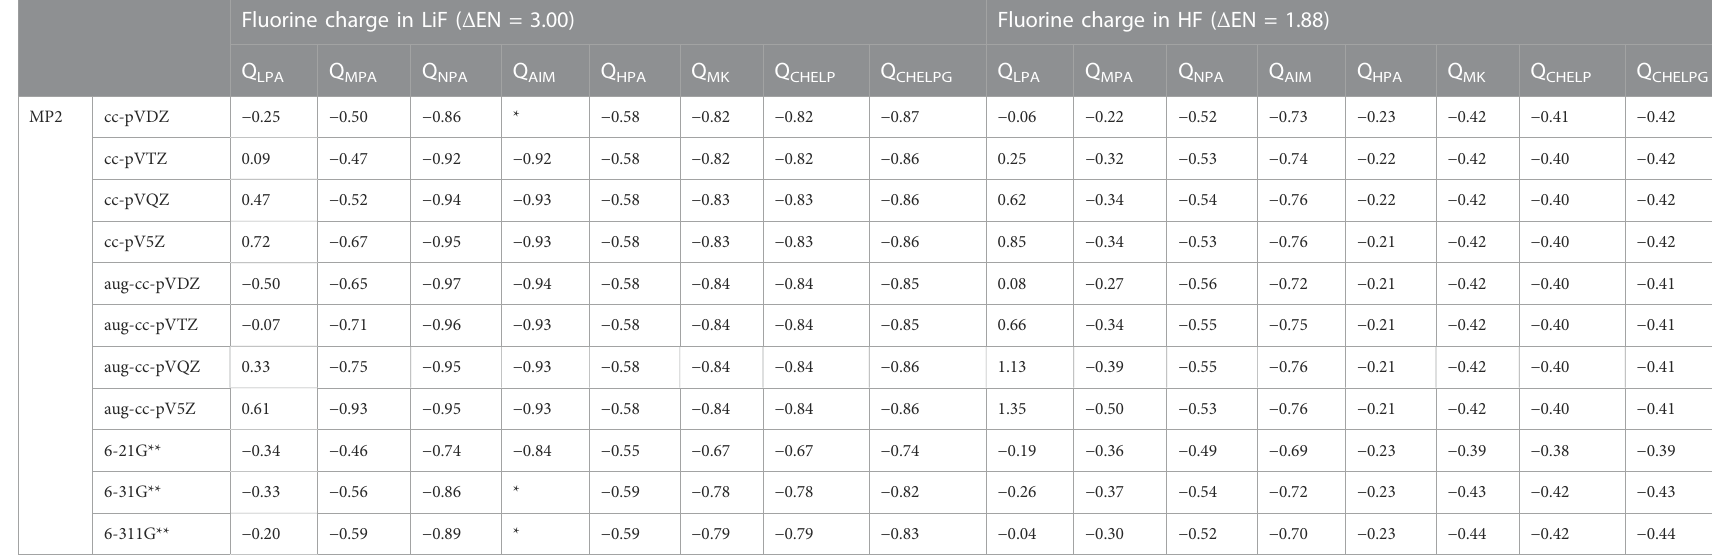
TABLE 2 Comparison of charges obtained for the most polar (LiF) and least polar (HF) diatomic molecules, using MP2 with different population analysis schemes and basis sets. Fluorine charge in LiF ( Δ EN =